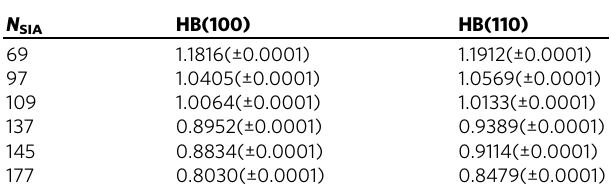
Fig. 2. If the loop jumps between (a) and (b), (b) and (c) or (between (a) and (e), (e) and (f)) the loop only moves its center of mass a distance of 1/6, 1/3, or half of the Burgers vector. If the state changes from (a) to (d) through the path marked by the red planes and from (d) to (a) through the path marked by the green planes (or from (a) to (g) by the red planes and (g) to (a) by the